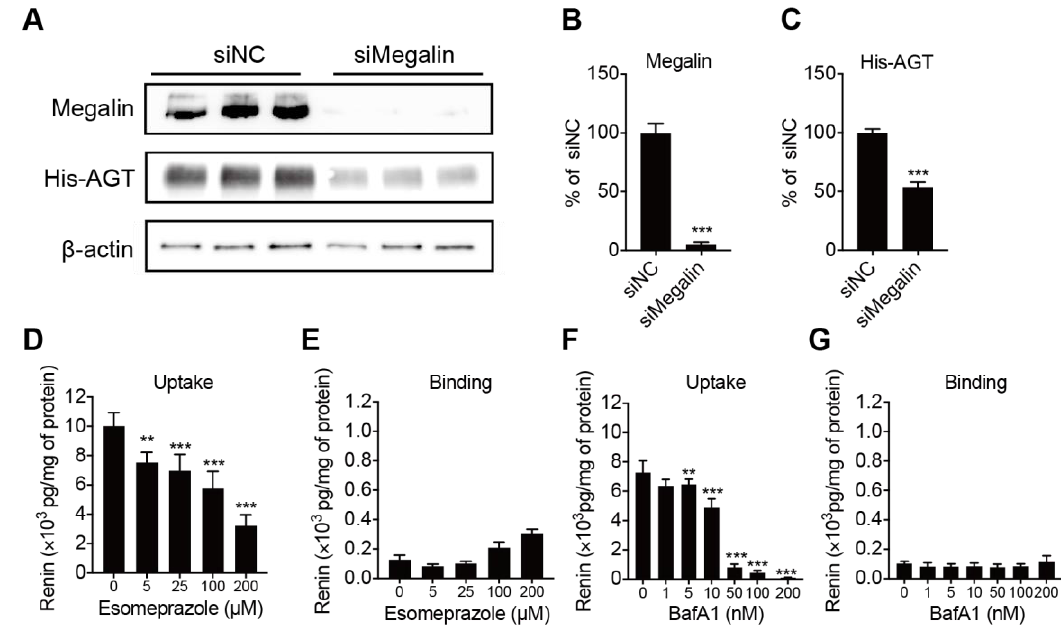
Figure 4. Panels ( A – C ): representative blots of His-AGT protein abundance in BN16 cells treated with negative control (siNC) or siRNA against megalin (siMegalin). Panels, ( D – G ): cell-associated renin levels after incubating BN16 cells with 100 U/L renin at 37 °C ( D , F ) or 4 °C ( E , G ) for 2 h in the presence of increasing concentrations of esomeprazole ( D , E ) or bafilomycin A1 ( F , G ). Data are mean ± SEM of n = 5–9. ** p < 0.005, *** p < 0.0005 vs. control.